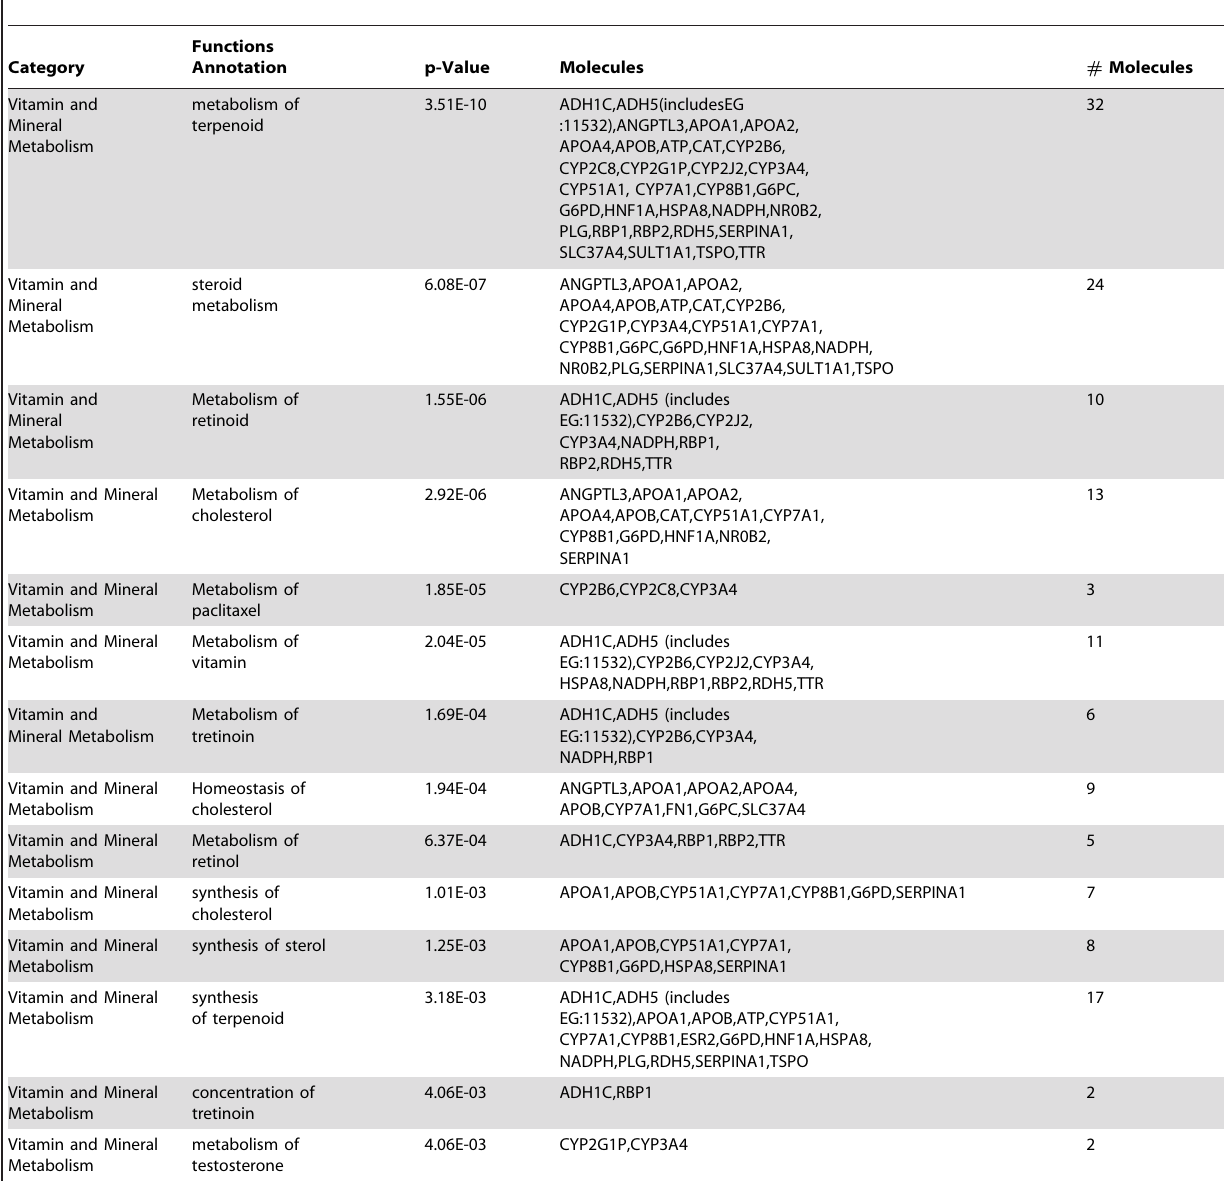
Table 6. Vitamin and mineral metabolism relevant gene transcripts affected by the two experimental diets in liver of rainbow